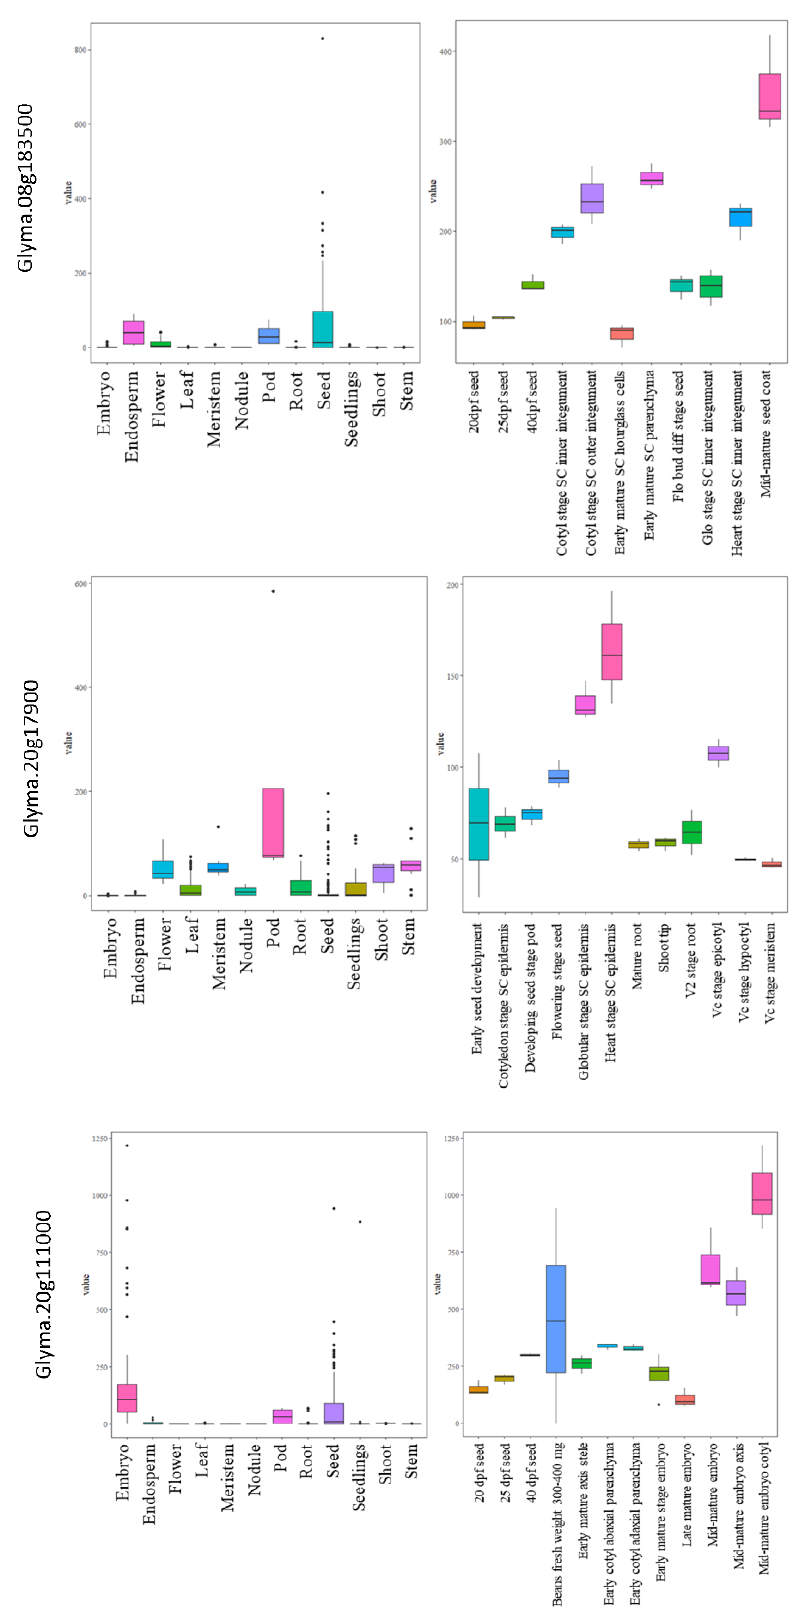
Figure 5. Expressions of genes in different tissues and developmental stages present within the meta-QTL region, ( a , c ) genes related to seed oil and protein metabolism/synthesis, ( b , d ) the transcription factors, ( e , f ) transporter genes.